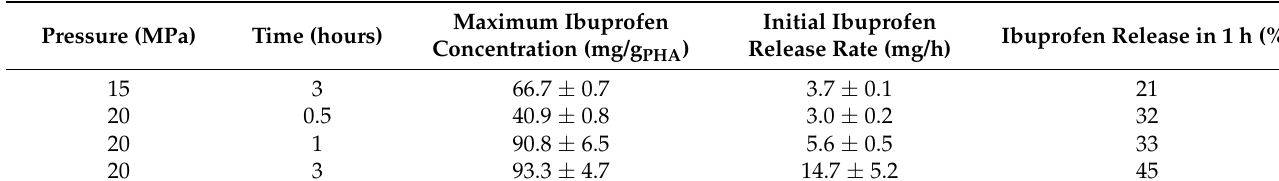
Table 1. Impregnation conditions of pressure and time and the obtained ibuprofen impregnation yield on mcl-PHA (mg/g PHA ), initial ibuprofen release rate to PBS (mg/h) and ibuprofen release during the first hour (%). Results are presented as mean ± SD and experiments were performed in duplicate.